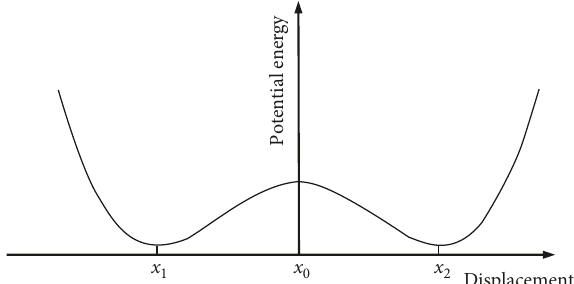
Figure 4: Potential energy distribution of the bistable vibration